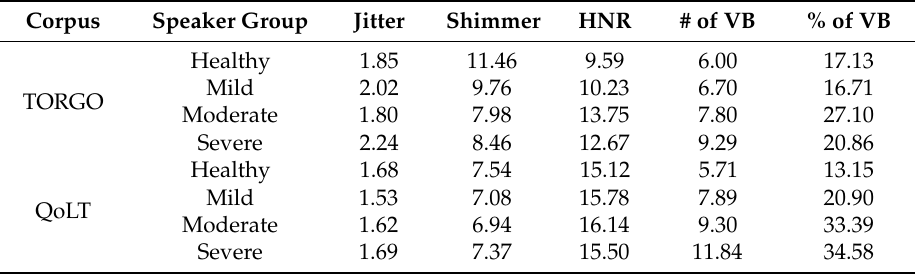
Table 5. Mean values for voice quality measures from TORGO and QoLT